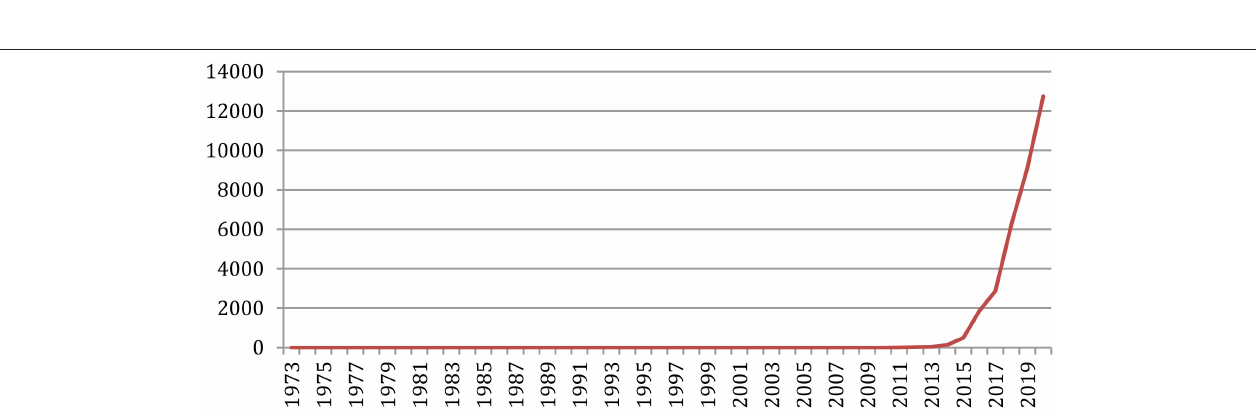
FIGURE 28 | Average number of references per paper globally (blue) or only to NLP4NLP papers (red).